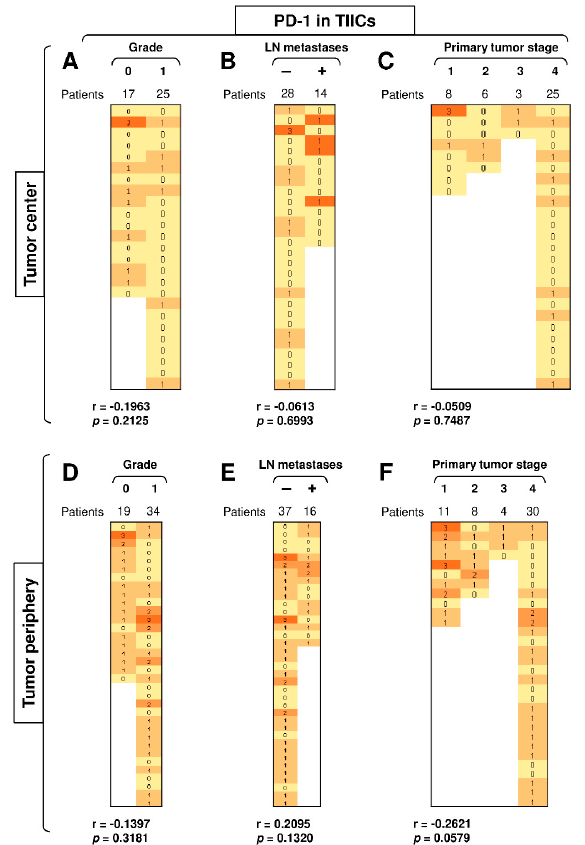
Figure 4. Disease severity does not correlate with the expression of PD-L1 and PD-1 in TIICs. ( A ) The cohort of 42 SGC patients was stratified into 2 groups according to tumor grade (grade 0 and grade 1), and the Spearman correlation with the expression of PD-1 in TIICs in the tumor center was determined. ( B ) The patient cohort in ( A ) was stratified into 2 groups according to the presence ( + ) or absence ( – ) of LN metastases, and the Spearman correlation was determined as in ( A ). ( C ) The patient cohort in ( A ) was stratified into 4 groups according to the primary tumor stage, and the Spearman correlation was determined as in ( A ). ( D – F ) The cohort of 53 SGC patients was stratified into groups as in ( A – C ), and the Spearman correlation with the expression of PD-1 in TIICs in the tumor periphery was determined. In ( A – F ), the correlations were evaluated by Spearman correlation tests, ( A – C ): n = 42, ( D – F ): n = 53. * p < 0.05 was considered significant. In ( A – F ), the expression analyses of PD-1 were performed according to the scoring system described in the Materials and Methods Section. The data are presented as a heat map with the scores. The color scale is presented as follows: yellow color: score 0; marigold color: score 1; ochre color: score 2; bronze color: score 3.